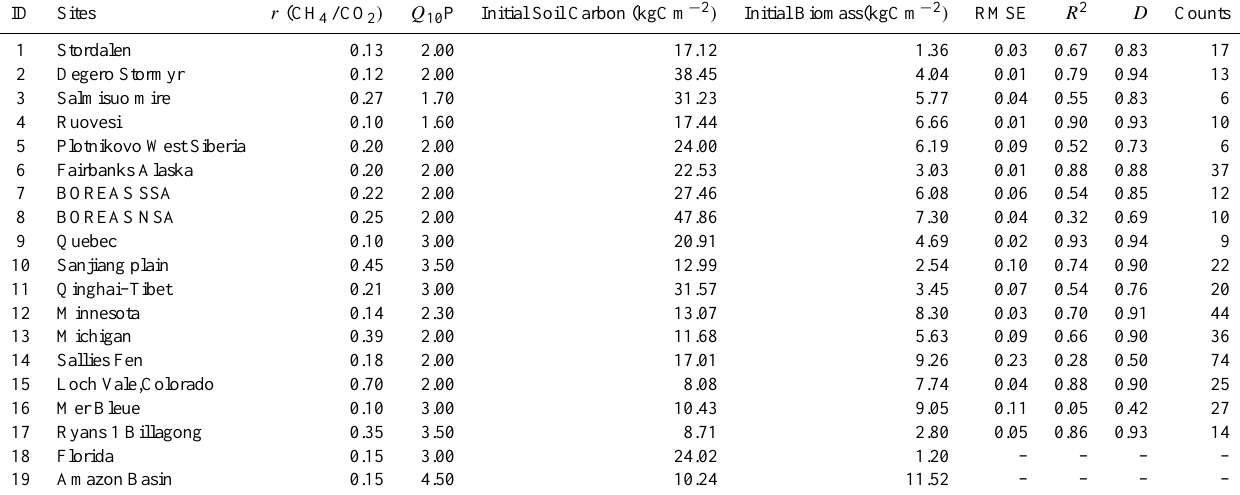
Table 3. List of calibrated values for the parameters of r and Q 10 P, the initial soil carbon and biomass conditions, and the model performance criteria indices for each